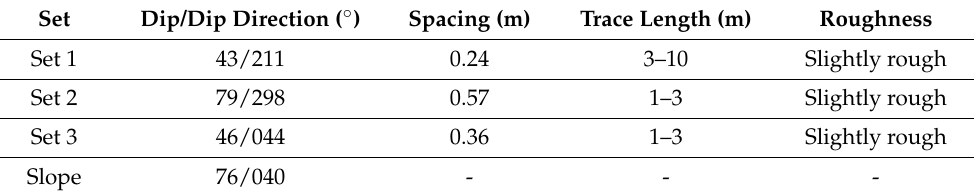
Table 10. Characteristics of the discontinuity sets in Slope-3